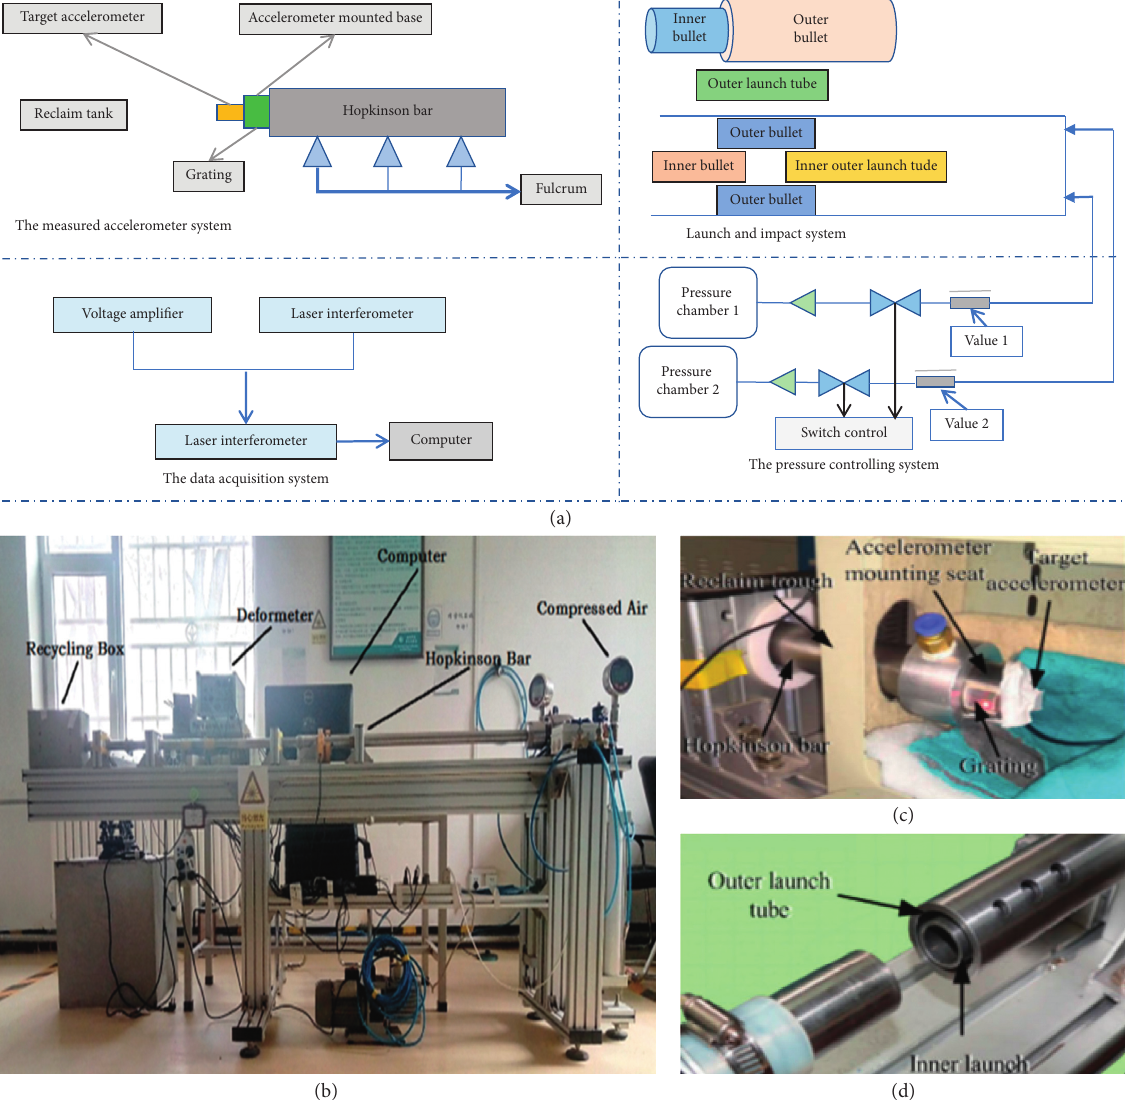
Figure 6: Hopkinson bar calibration